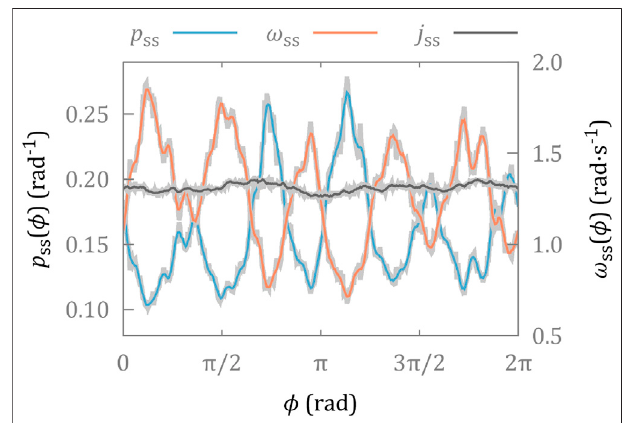
FIGURE 2 | Steady state distributions of the orientation, p ss ( ϕ ) , angular velocity, ω ss ( ϕ ) and probability current, j ss . Thedataare averaged over ≈ 175 revolutions, using bins of width 1 ° . In each case, the raw data (gray) is overlayed with the smoothed data. The scale used for j ss is numerically equivalent to that used for p ss ( ϕ ) , with units